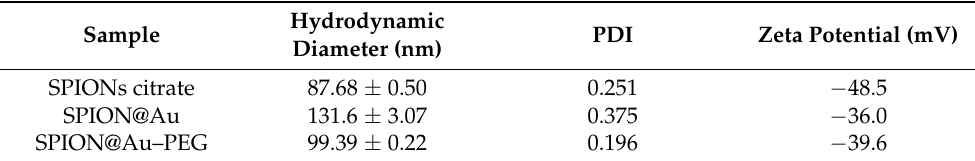
Figure 2. TEM images of synthesized SPIONs citrate ( a ), SPION@Au ( b ), and SPIONs@Au–PEG ( c ). Table 1. Values of average hydrodynamic diameter, zeta potential and polydispersity index (PDI) of the SPION@Au and SPION@Au–PEG